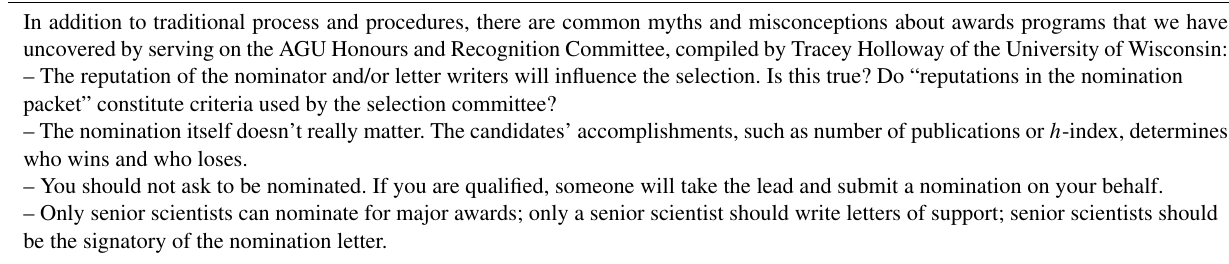
Table 1. Common myths and misconceptions about awards